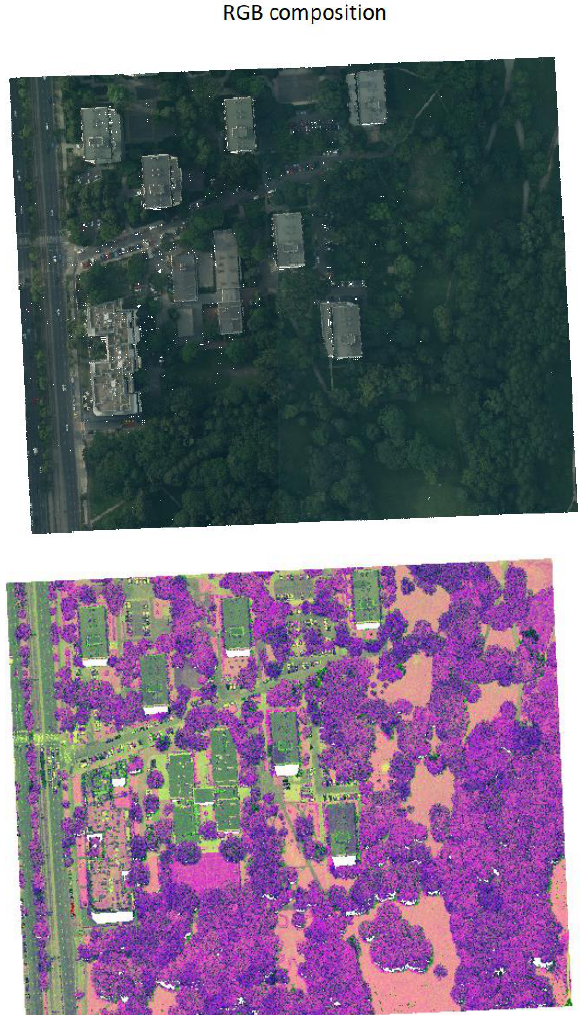
Fig. 1 Top view of the point cloud presented as RGB composition, where Red is intensity registered in near infrared, Green - in green and Blue band corresponds with the GNDVI